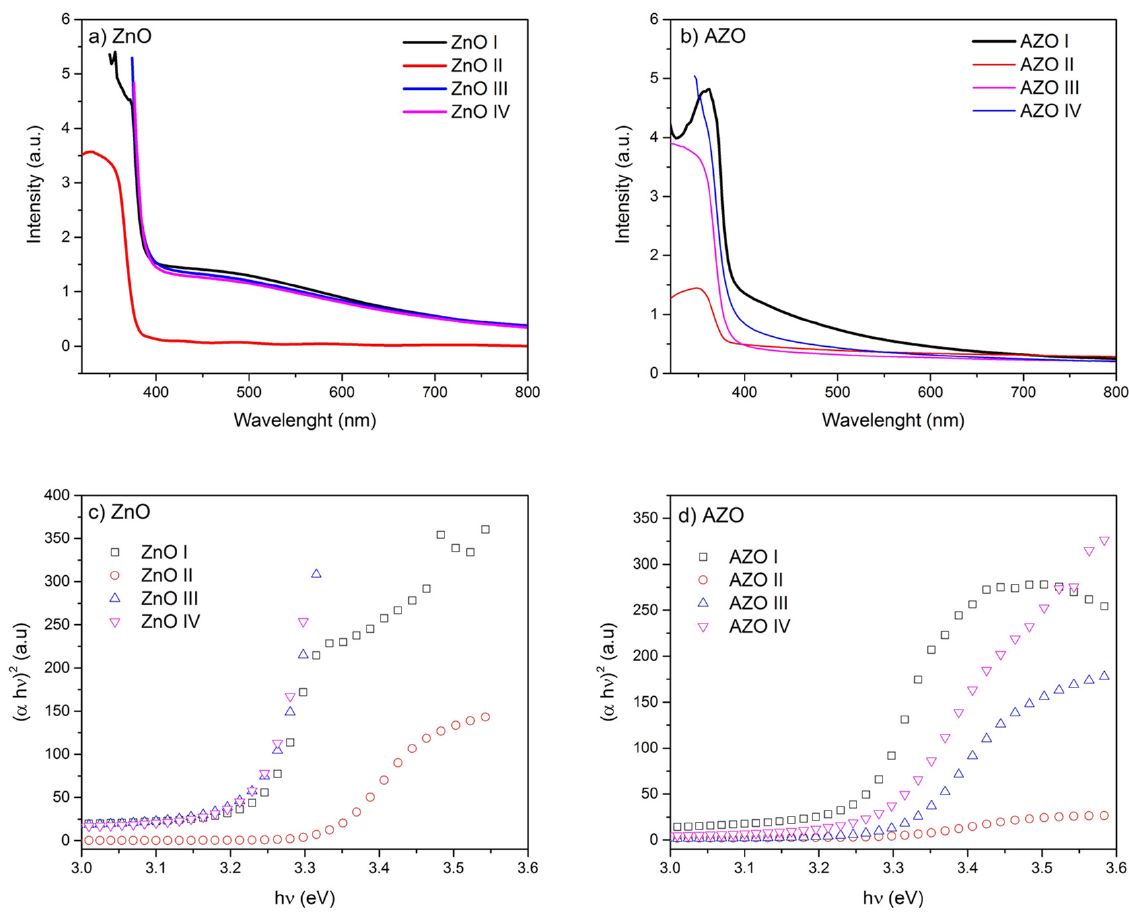
Figure 8. ( a , b ) UV-Vis absorption spectra and ( c , d ) the corresponding Tauc plots of ZnO and AZO samples.